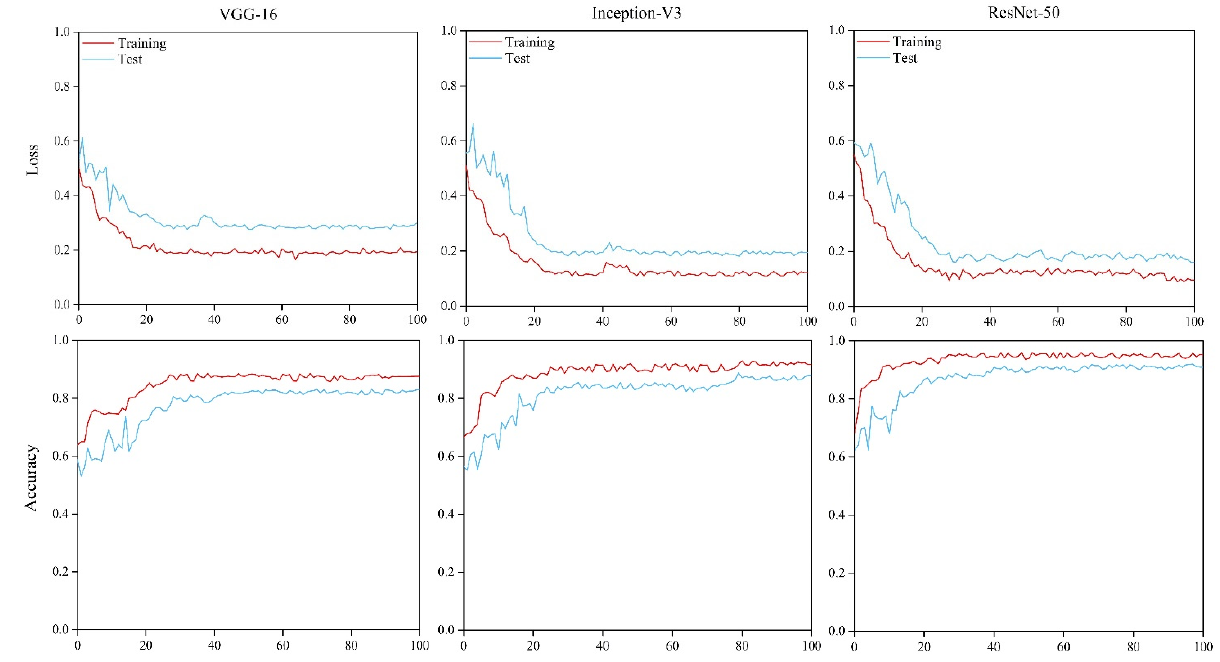
Figure 12. Accuracy and loss for the training and test sets of the three algorithms through RGB images. Table 3. Performance of the three algorithms for the test sets of RGB images.